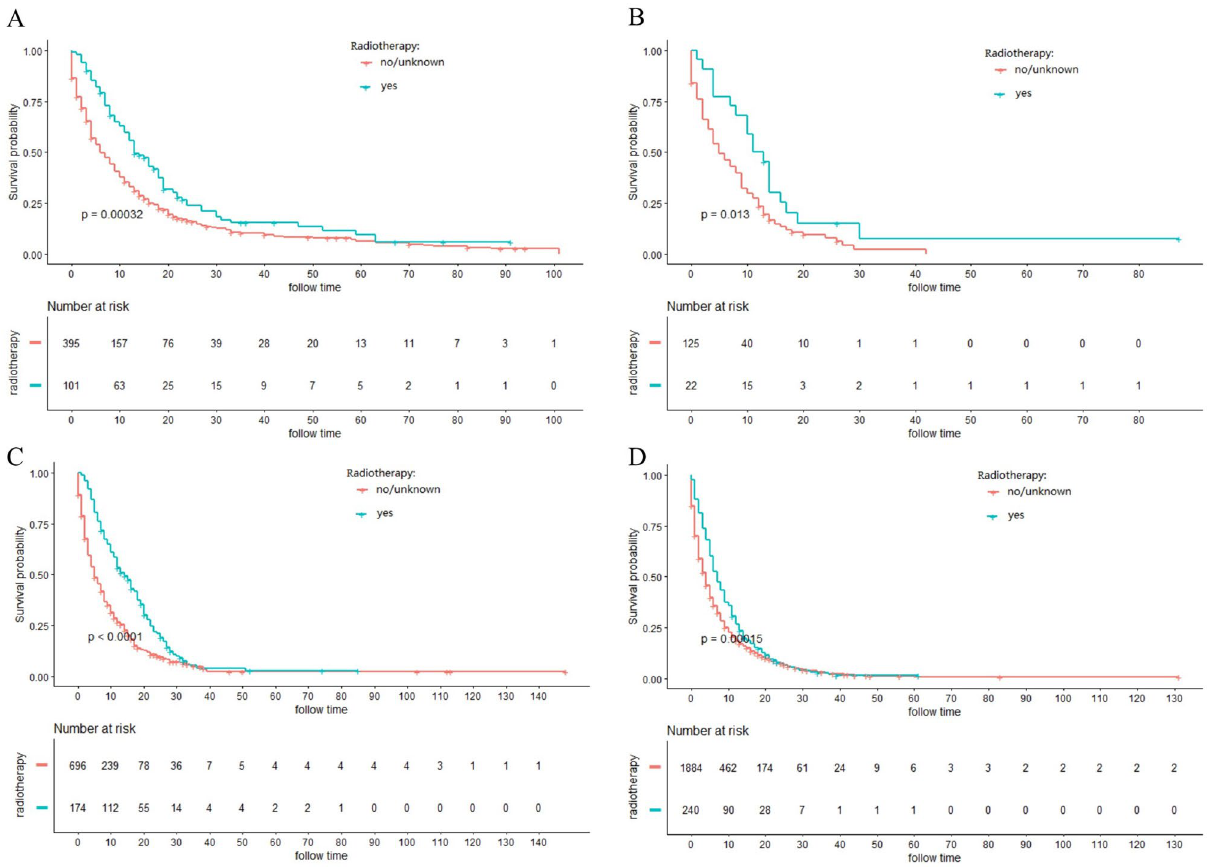
Figure 6. Kaplan–Meier curves for overall survival (OS) in different AJCC stage between radiotherapy and no-radiotherapy groups in unresectable ICC patients: ( A ) stage I; ( B ) stage II; ( C ) stage III; ( D ) stage IV.